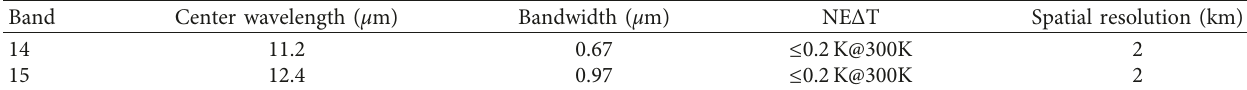
Table 1: Instrument specifications for